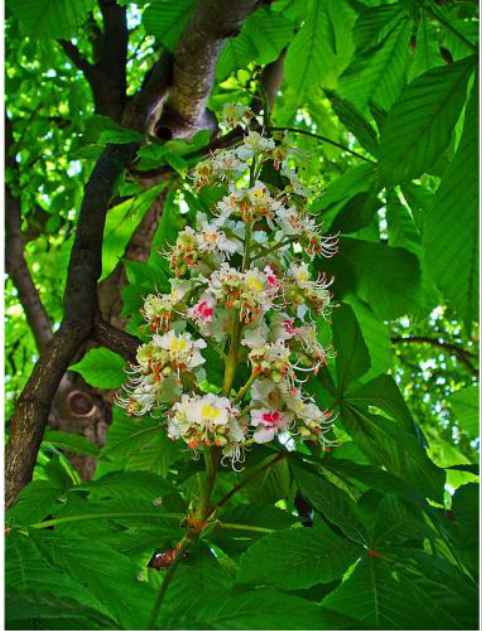
Figure 7. Aesculus hippocastanum L.